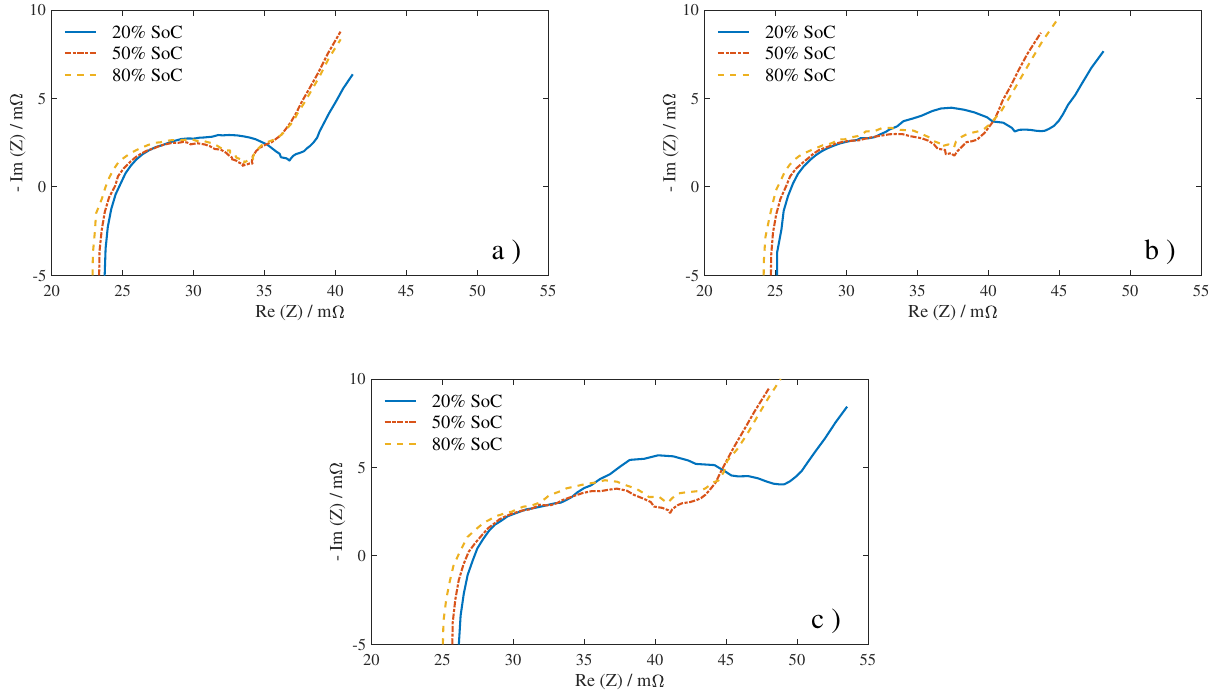
Figure 13. Electrochemical impedance spectra obtained with 500 mA current excitation for the battery tested under 45 ◦ C@0.5–1 C condition after: ( a ) 50 cycles; ( b ) 150 cycles; and ( c ) 250